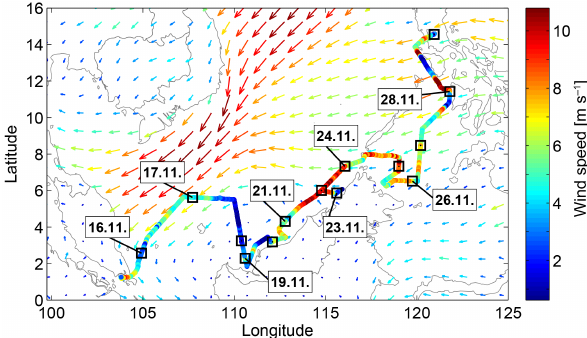
Figure 1. ERA-Interim mean wind field 15–30 November 2011 (ar- rows) and 10min running mean of wind speed observed on R/V Sonne as the cruise track. The black squares show the ships position at 00:00UTC each